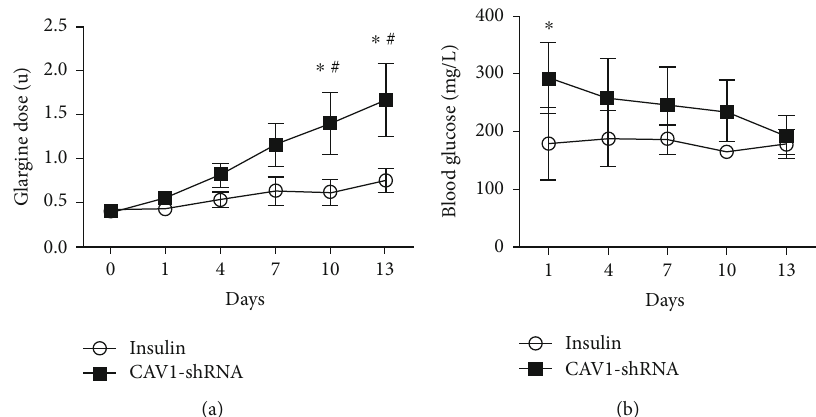
Figure 6: The doses of glargine required to maintain blood glucose in the CAV1-shRNA and insulin groups (a). The fl uctuation of blood glucose in the CAV1-shRNA and insulin groups (b) (data are expressed as mean ± SEM . ∗ P < 0 : 05 compared with the insulin group, n = 5 ).